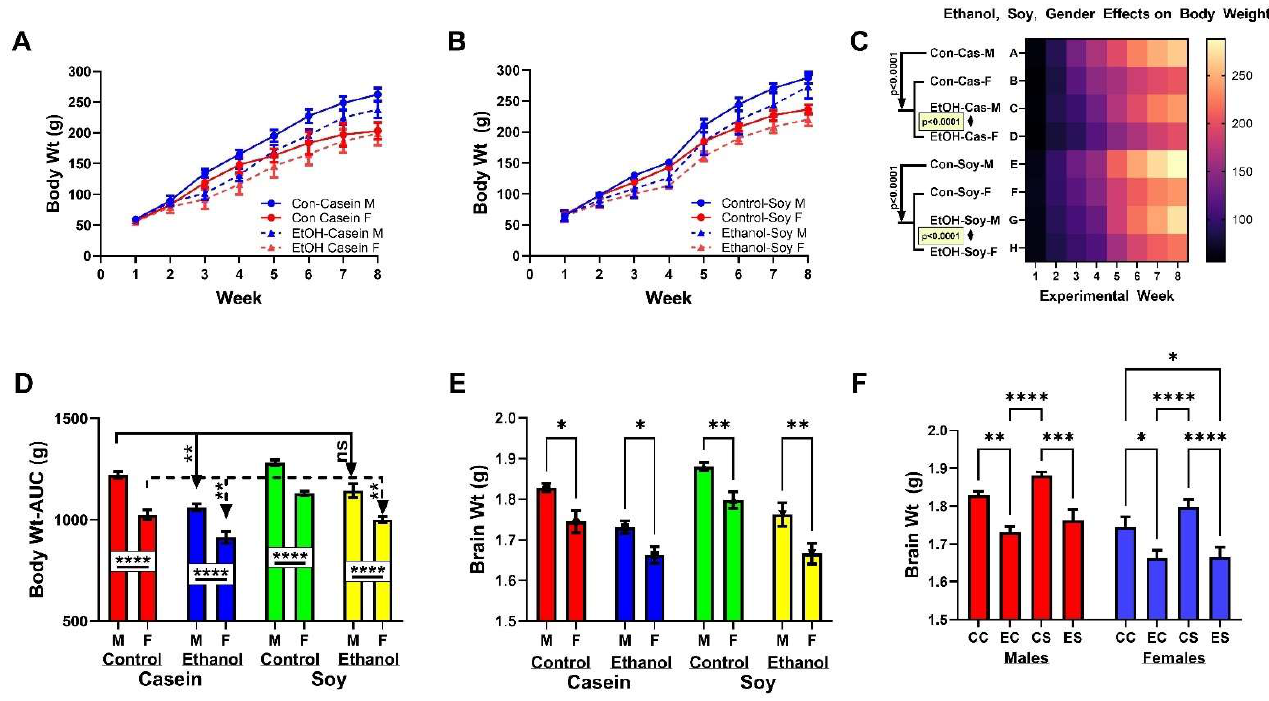
Figure 1. Effects of chronic ethanol and dietary soy isolate on body growth and brain weight in male and female adolescent Long Evans rats. A four-way model was generated with 12 rats per group (6 male, 6 female): Control + Casein, Ethanol + Casein, Control + Soy, Ethanol + Soy. From 4-weeks of age, rats were maintained for 7 weeks on isocaloric Lieber–Decarli liquid diets containing 0% or 37% (3 weeks) followed by 26% (4 weeks) (caloric) ethanol and with casein (standard) or soy isolate (experimental) protein. Weekly body weights were measured to compare sex and ethanol effects with ( A ) casein or ( B ) soy as the dietary source of protein. ( C ) Heatmap comparisons of body weight changes over time for all groups showing consistently lower mean weights with female sex and ethanol-exposure, and increased body weight in soy compared with corresponding casein groups. ( D ) Area-under-curve body-weight calculations over the 7-week study confirming results in Panel C and showing soy’s protective effects in ethanol-fed males but not females relative to casein controls. ( E , F ) Brains were weighed at sacrifice.